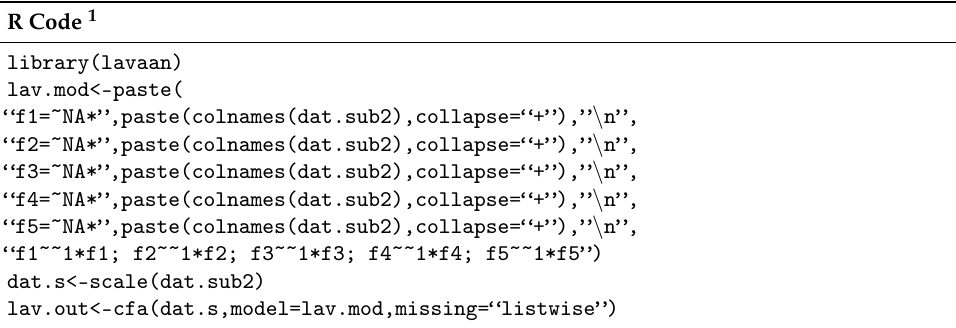
Table 1. R code for constructing the model and organizing